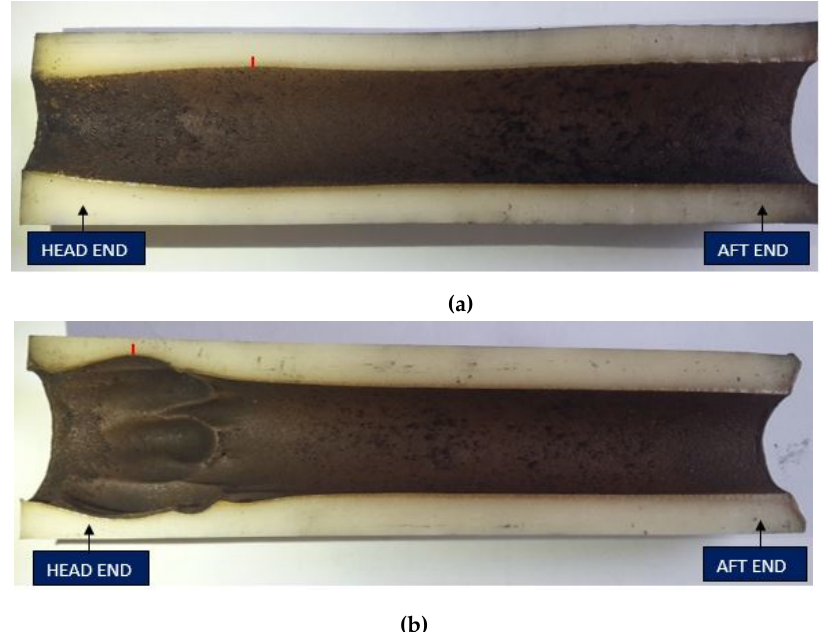
Figure 8. Burnt PVC grain using ( a ) shower head injector and ( b ) multi-angle diverging injector.